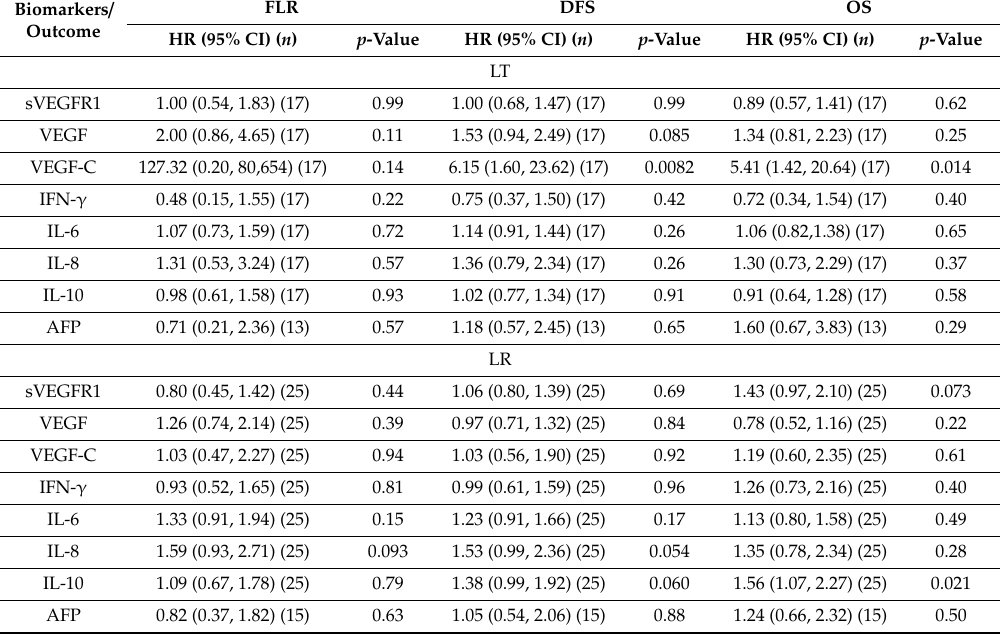
Table 6. Association between selected plasma biomarkers and freedom of liver recurrence (FLR), disease-free survival (DFS) and overall survival (OS) in hepatocellular carcinoma patients outside Milan criteria who underwent surgical treatments. p -value from Wald test in a univariable Cox regression using log-transformed